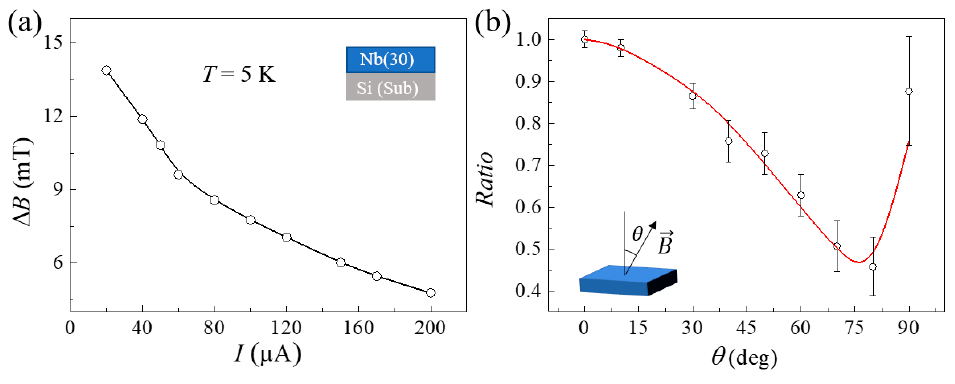
θ ∆ B θ (cid:3299)(cid:3299)(cid:3335) ∆(cid:3003) (cid:3335) xx (red line) and the ∆ B ⊥ (red line) and the P ⊥ xx (cid:3017) (cid:3299)(cid:3299)(cid:3132) ∆(cid:3003) (cid:3132)